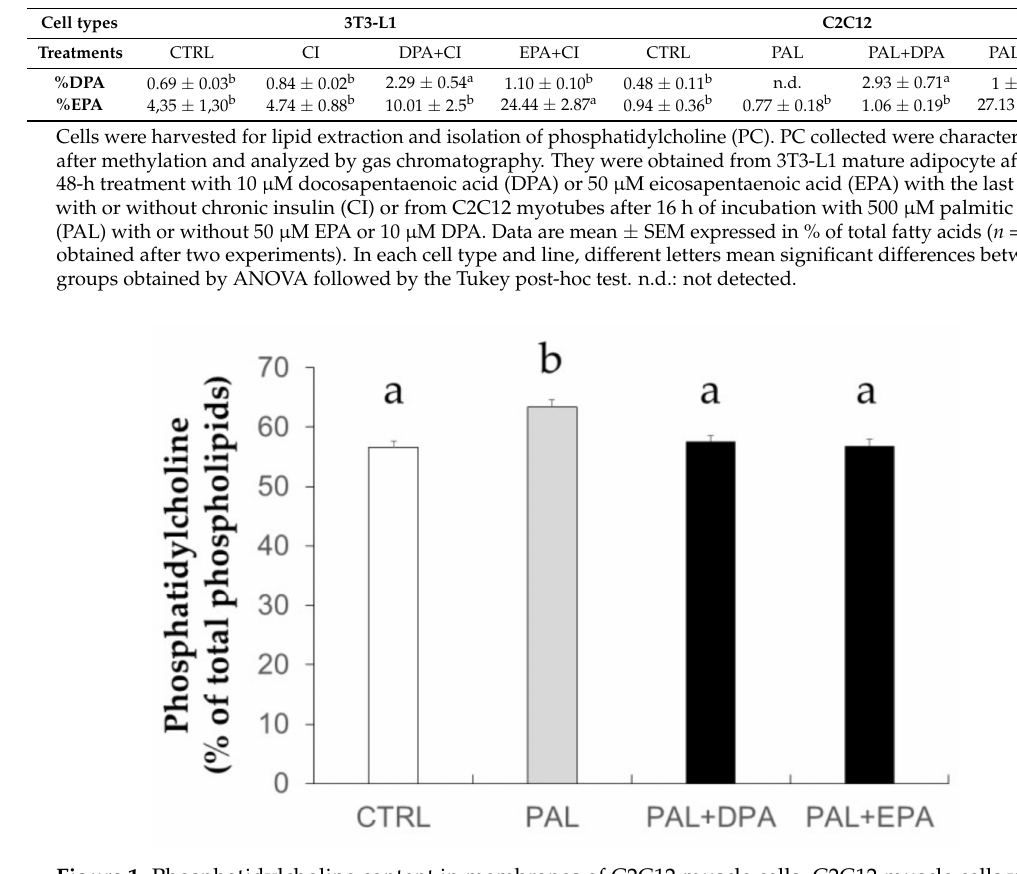
Figure 1. Phosphatidylcholine content in membranes of C2C12 muscle cells. C2C12 muscle cells were treated with 500 µ M palmitic acid (PAL) with or without 10 µ M docosapentaenoic acid (DPA) or 50 µ M eicosapentaenoic acid (EPA). Cells were harvested for lipid extraction and phospholipids were separated by high performance liquid chromatography (HPLC). Phospholipid classes were quantified and expressed as the percent of total phospholipids. Data are mean ± SEM ( n = 4–6 obtained after three experiments). Different letters mean significant differences ( p < 0.05) between groups obtained by ANOVA and the Tukey post-hoc